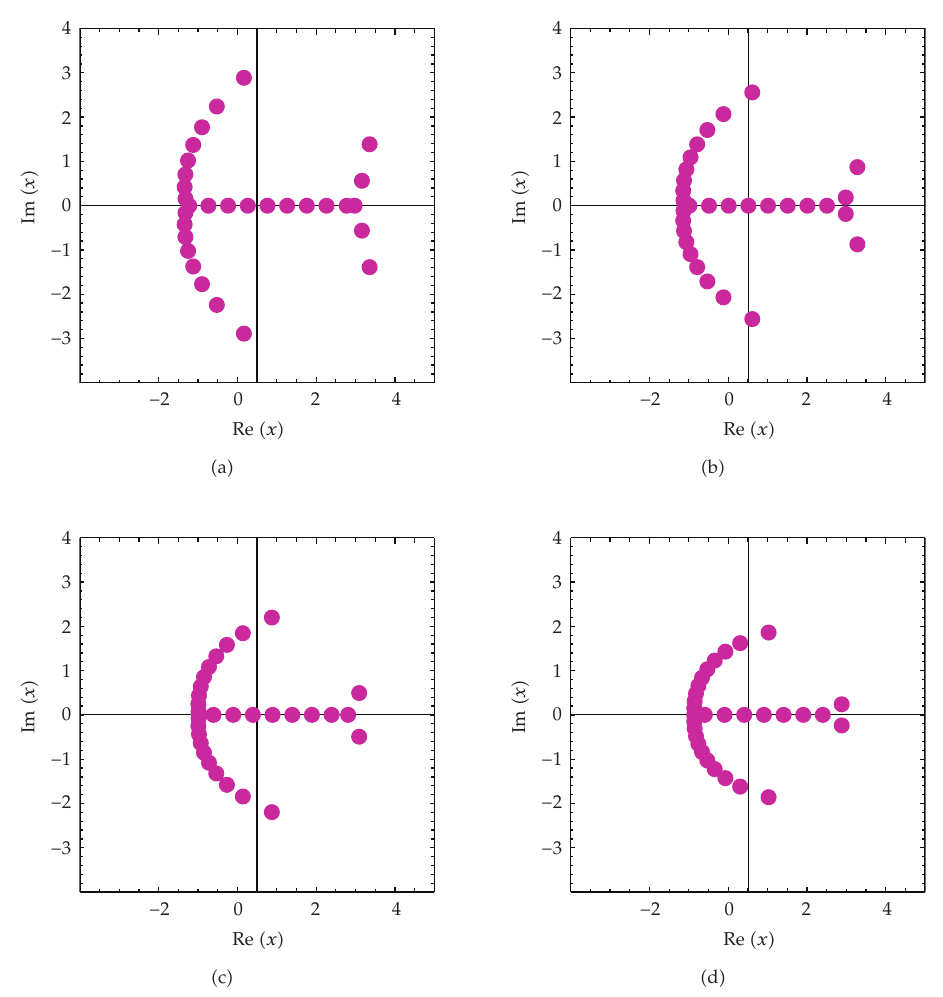
Figure 3: Zeros of B 30 , 1 / 2 (cid:2) x (cid:3) for h (cid:6) 5 , 7 , 9 ,